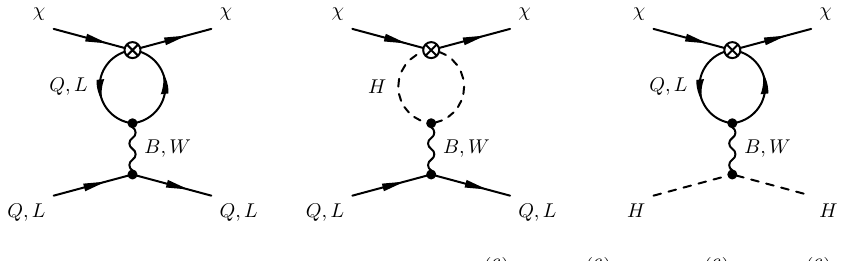
; : : : ; Q (6) and Q (6) ; : : : ; Q (6) due to the 15 18 1 ;i 14 ;i